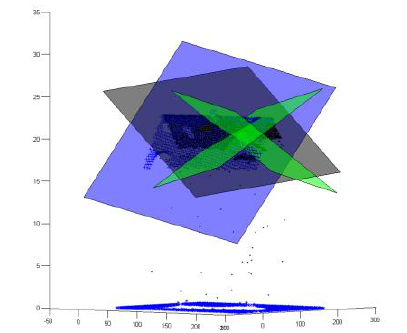
Figure 10: Point cloud from figure 9 highlighted in blue; the two major roof planes are marked in blue and black and the two smaller planes in green.